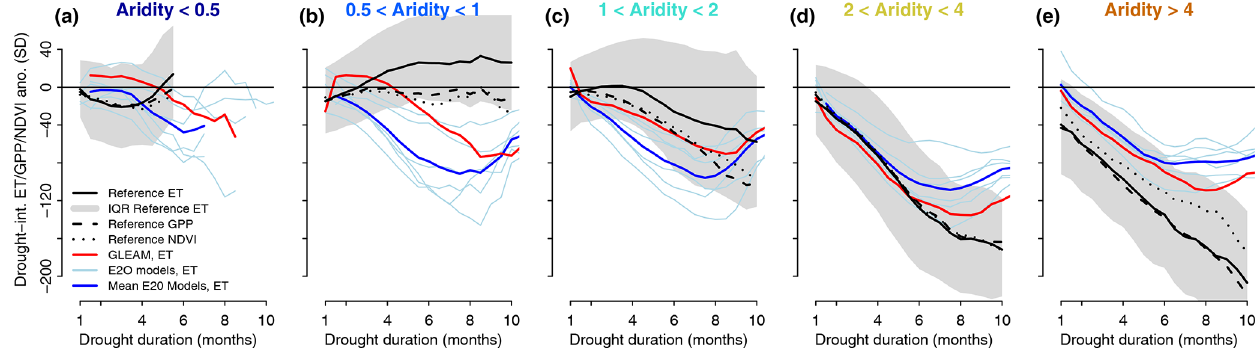
Figure 4. Drought duration control on biospheric drought response in observations and models. Response of drought-integrated biospheric anomalies across observation-based reference data (ET, NDVI, and GPP as displayed in Fig. 3), as well as for modelled ET (GLEAM and Earth2Observe models).